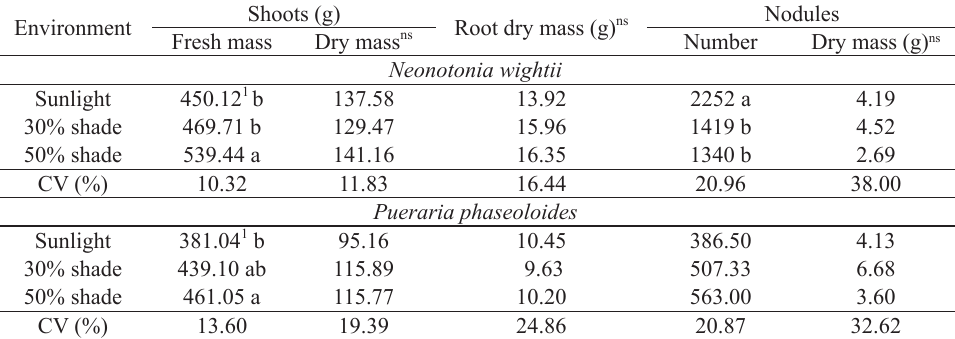
Biomass accumulation in the shoots and roots, as well as nodulation, of Neonotonia wightii and Pueraria phaseoloides cultivated under different light